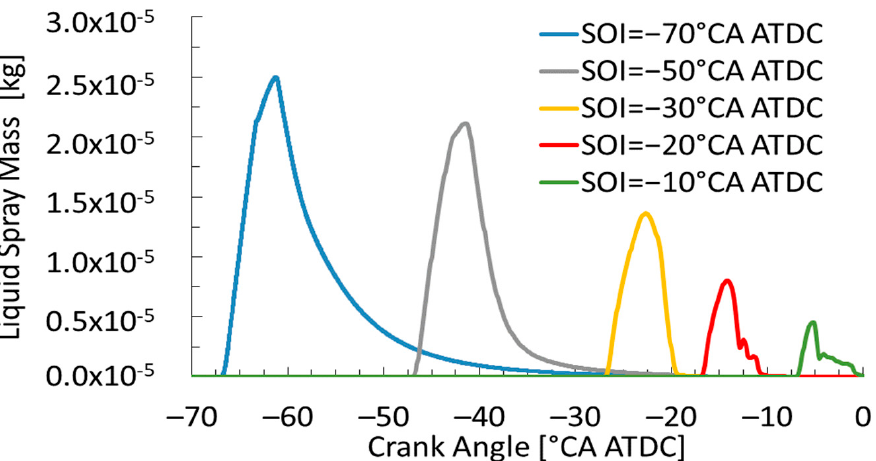
Figure 17. Effect of SOI on in-cylinder liquid fuel mass content history according to ◦ CA ATDC. STPL in the radial direction according to ◦ CA after SOI for various SOI timings is presented in Figure 18. For the early injection cases, STPLs are higher than those for the late injection cases due to lower ambient pressure and density in the cylinder. For early injection timing cases, that is, SOI timings of − 70 ◦ CA and − 50 ◦ CA ATDC, fuel sprays impinge directly onto the cylinder liner at 4.4 and 4.9 ◦ CA after SOI, respectively, and form wall films which spread on the liner. For an SOI of − 70 ◦ CA ATDC, subsequent spray droplets impinging on the liquid film that has formed on the cylinder liner partially splash back into the squish volume, as shown in Figure 16a. Then, splashing droplets of neighboring sprays interact with each other in the squish volume located between the piston top and cylinder head, while liquid films spread on both the squish area on top of the piston and cylinder head. Most of the droplets and liquid films evaporate before the start of auto-ignition at − 25.8 ◦ CA ATDC. On the other hand, for an SOI of − 50 ◦ CA ATDC, fuel films formed on the cylinder liner and piston top evaporate completely, and a minor number of droplets exist near the injector nozzles when the mixture auto-ignites at − 25.3 ◦ CA ATDC.